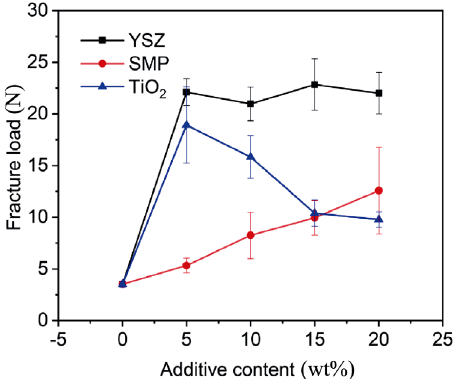
Fig. 3 Effects of the additive contents on the fracture load of the mullite hollow fiber membranes sintered at 1570 ℃ .